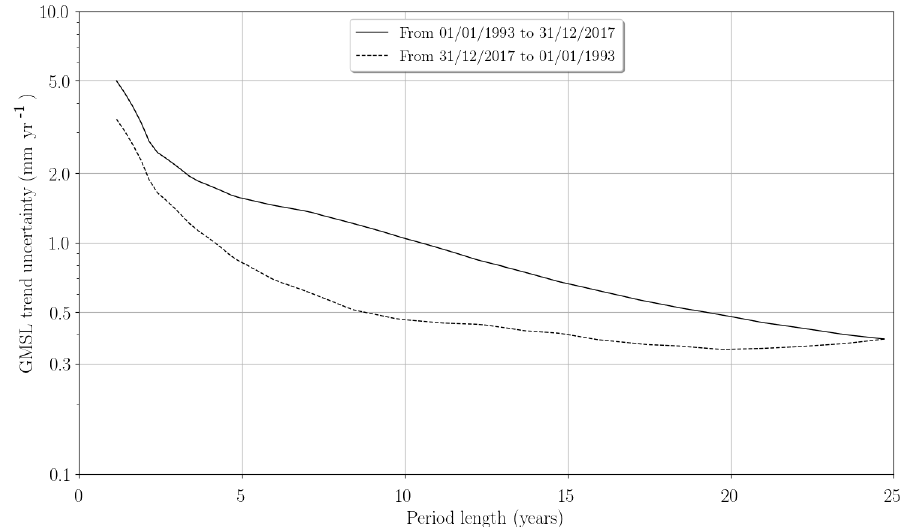
Figure 7. Evolution of the GMSL trend uncertainties within a 90% confidence level (1 . 65 σ ) versus the altimeter period length from Jan- uary 1993 to December 2017 on the plain curve and from December 2017 to January 1993 on the dashed curve.